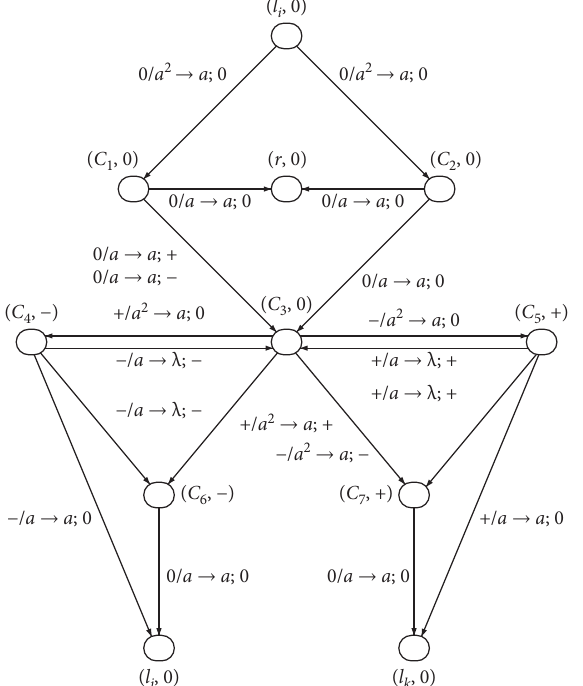
Figure 1: ADD module (simulating l